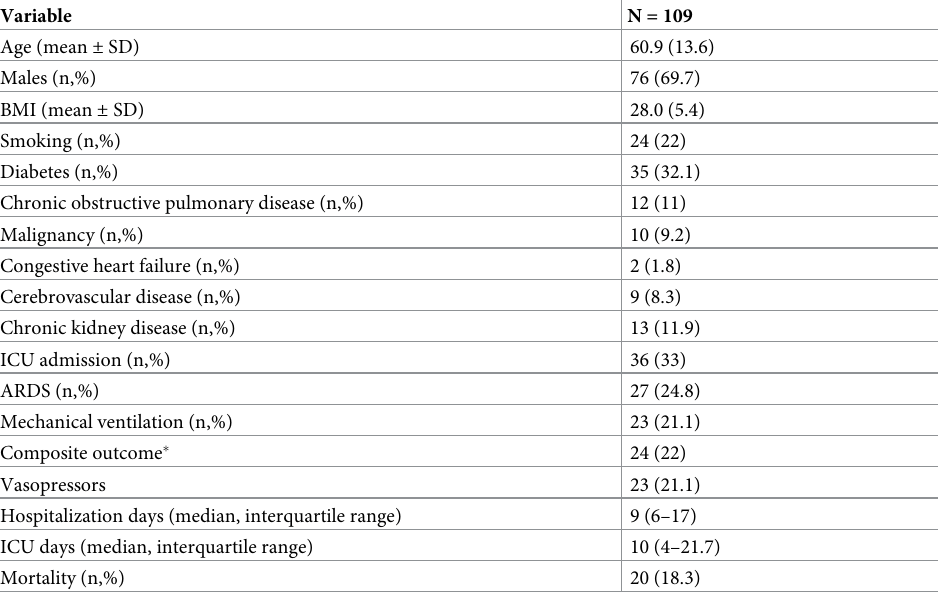
Table 2. Patients’ characteristics.